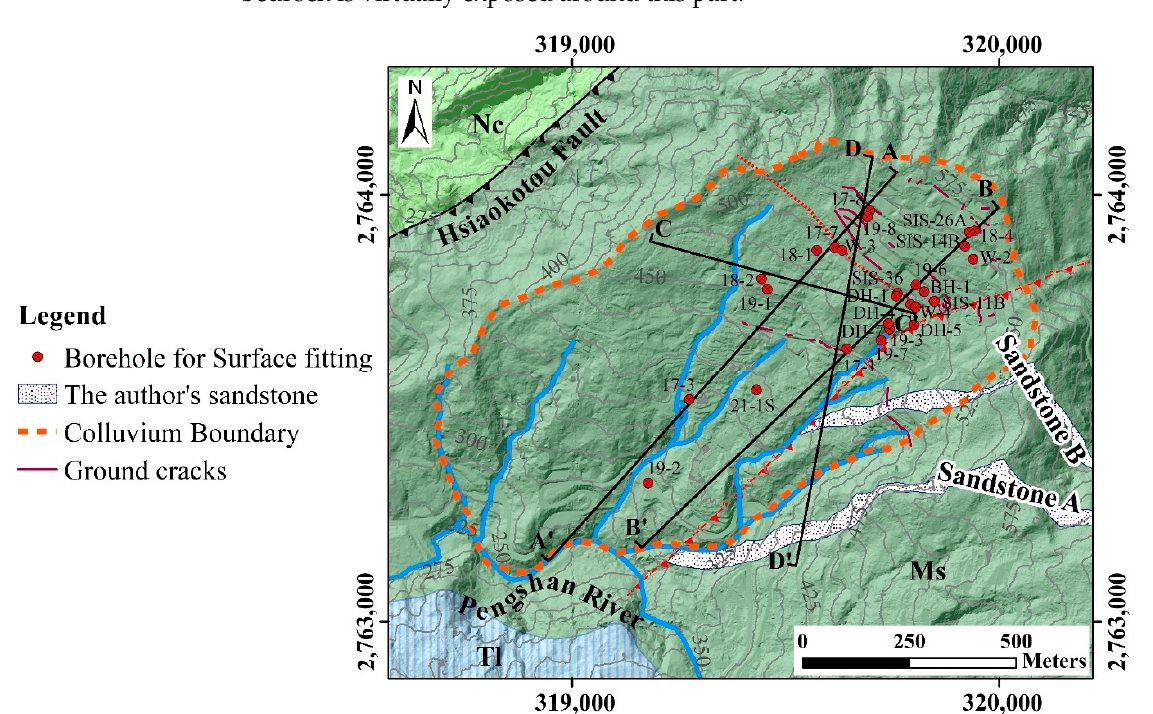
Figure 12. Distribution diagram of the four geological cross-section profiles and the borehole data. These borehole sources were gathered from available existing borehole logs in the study area. The deepest borehole was 100 m (BH-1), while the shallowest borehole was 25 m deep (SIS-26A). The red boreholes are projected along the contour line at the top of the key bed in the profiles (i.e., sandstone).